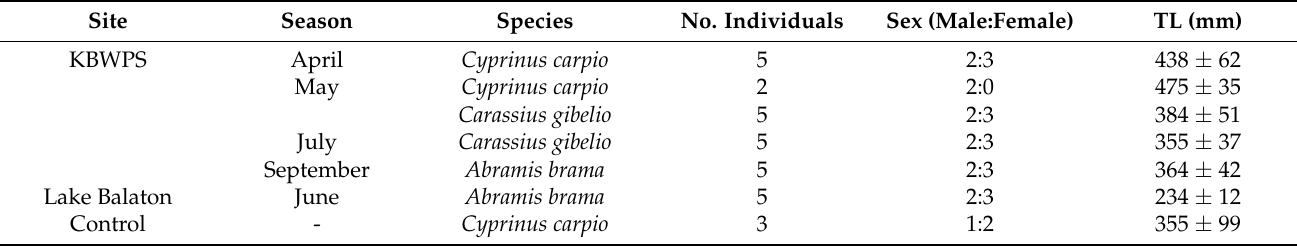
Table 1. Species, the number of individuals, sex ratio and mean total lengths (mm) of fish sampled from the Kis-Balaton Water Protection System (KBWPS) and Lake Balaton during the investigated period of 2018.